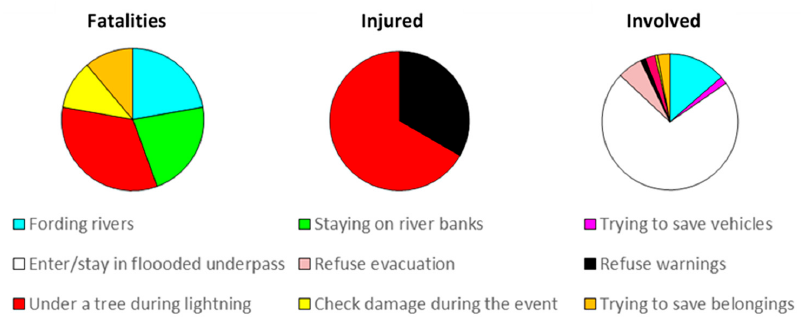
Figure 8. Damage severity and hazardous behaviors.